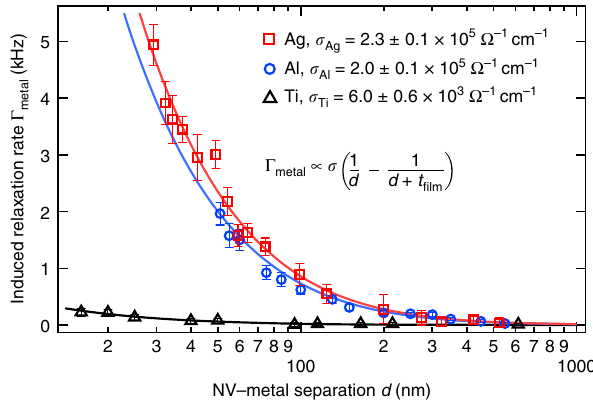
Fig. 2 Quantitative conductivity measurements using the NV center. Plotted is the metal-induced NV center relaxation rate Γ metal as a function of NV distance d from 85-nm thick fi lms of Ag (red squares), Al (blue circles), and Ti (black triangles). For each curve the intrinsic relaxation rate of the NV is measured and subtracted to isolate Γ metal . The fi ts (solid curves) yield the conductivity values shown. Error bars correspond to the standard error in the fi t to a full T 1 measurement at each